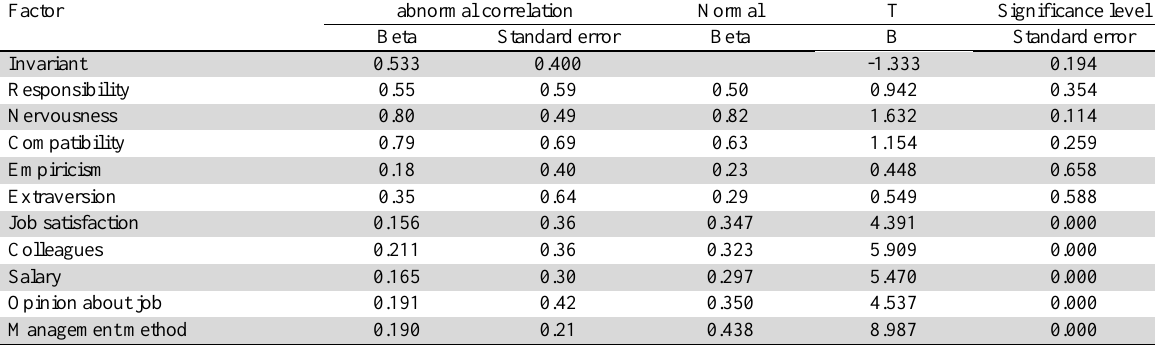
The results of stepwise regression analysis